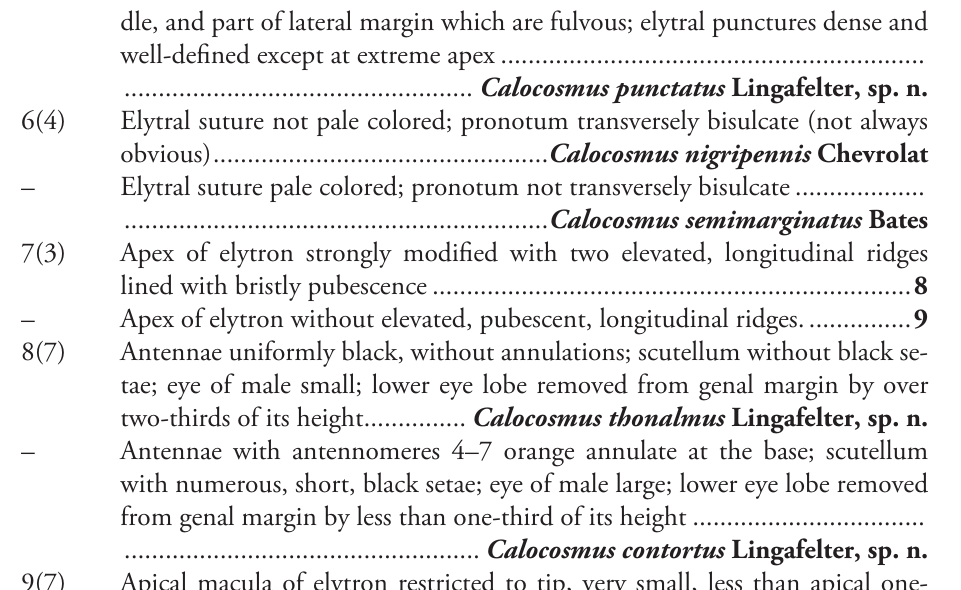
dle, and part of lateral margin which are fulvous; elytral punctures dense and